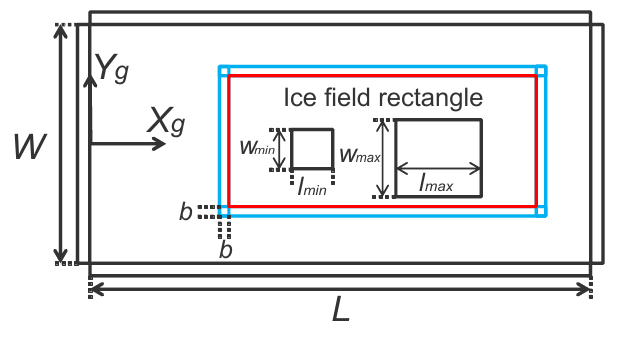
Figure 11: The ice field rectangle and its ”safety” margins.